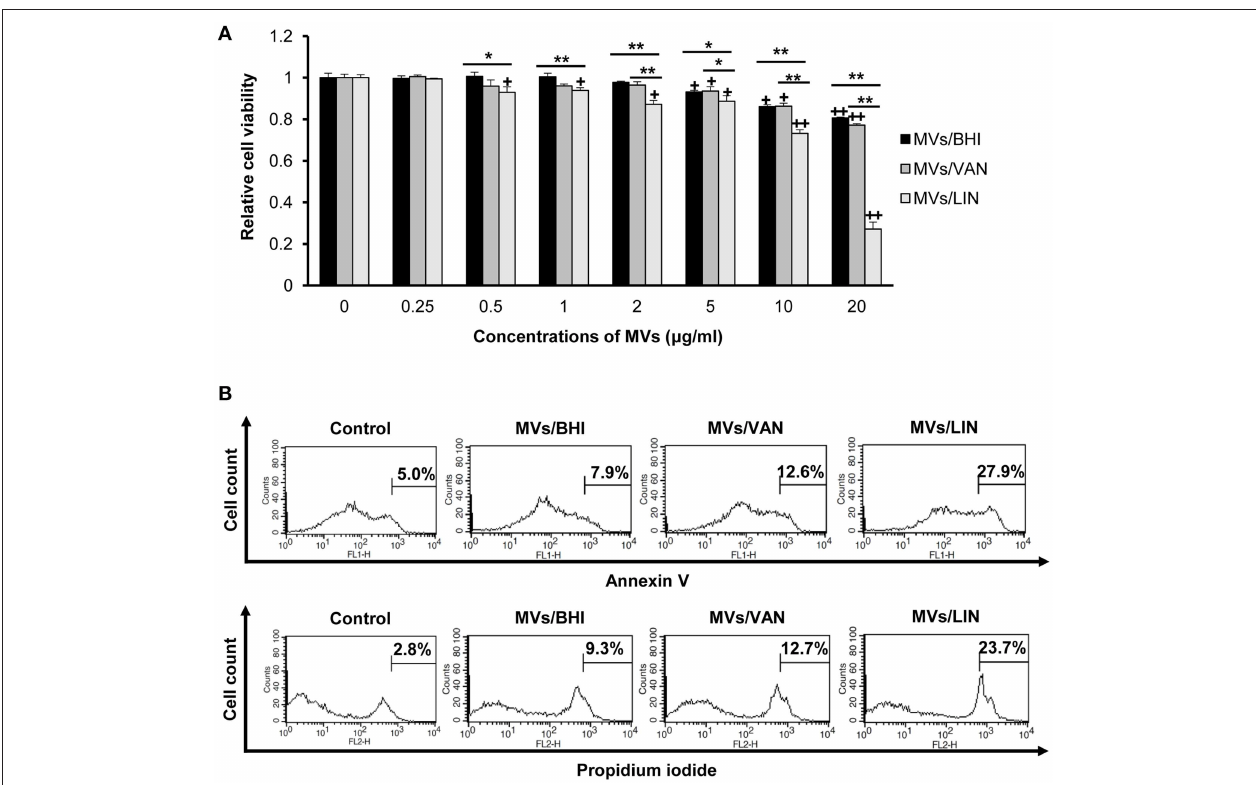
FIGURE 3 | Cytotoxicity of Caco-2 cells treated with MVs from E. faecium ATCC 700221. MVs were isolated from culture supernatants of E. faecium cultured in BHI broth (MVs/BHI), BHI broth with 256 µ g/ml vancomycin (MVs/VAN), or BHI broth with 1 µ g/ml linezolid (MVs/LIN). Cells were treated with various concentrations of E. faecium MVs for 24h. (A) Cell viability was determined using an MTT assay. Data are presented as the mean ± SD of three independent experiments. + P < 0.05, ++ P < 0.01 compared to untreated control cells. * P < 0.05, ** P < 0.01 among the same concentrations of MVs/BHI, MVs/VAN, or MVs/LIN. (B) Flow cytometric analysis of Caco-2 cell death induced by E. faecium MVs. Cells were treated with 20 µ g/ml of E. faecium MVs for 24h. Cells were stained with FITC-Annexin V and propidium iodide, and 10 4 cells were counted. The figure represents one of three independent experiments that yielded similar results.